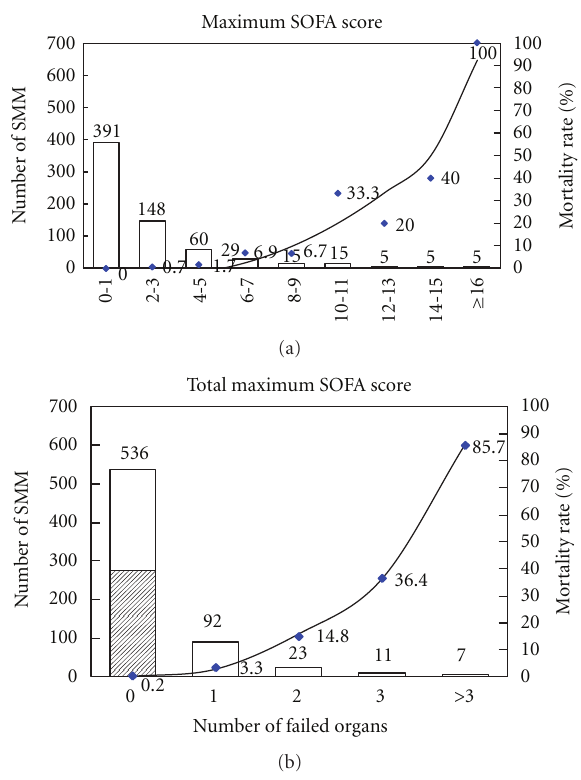
Figure 1: Number of severe maternal morbidity (SMM) patients (bar), mortality rate (symbol), and regression adjustment of mor- tality, according to total maximum Sequential Organ Failure Assess- ment (SOFA) score (a) and number of failed organs (b). Hatched area represents 273 cases of organ dysfunction